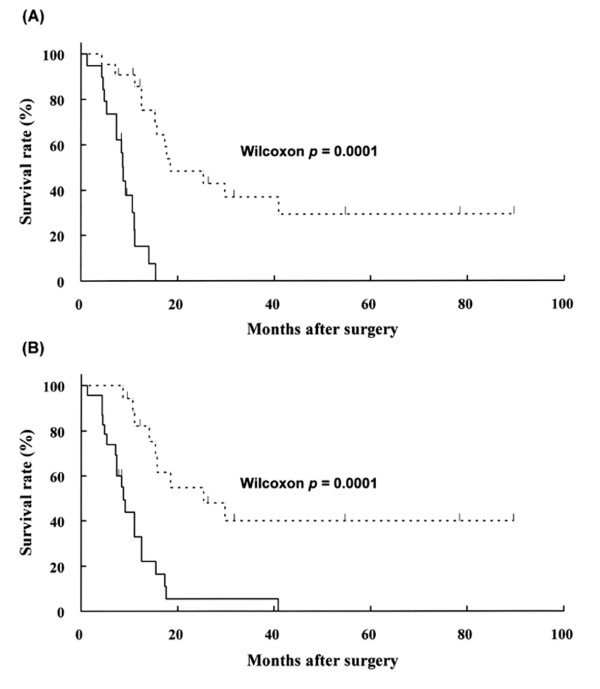
Kaplan-Meier survival curves for pancreatic cancer patients. (A) A comparison of survival curves between cases with (thick line) and without (broken line) strong expression of α6 integrin. (B) A comparison of survival curves between cases with (thick line) and without (broken line) strong expression of uPAR.